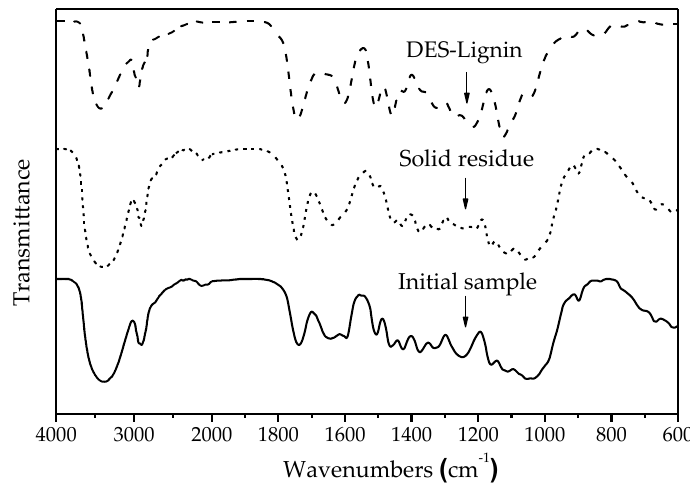
Figure 5. Fourier transform infrared spectroscopy (FT-IR) spectra of the initial sample, solid residue, and DES-Lignin. Table 3. Assignment of Fourier transform infrared spectroscopy (FT-IR)spectra of the initial sample, solid residue, and DES-Lignin.